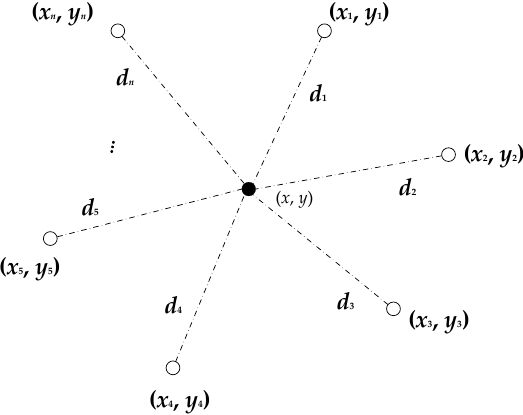
Figure 1. Schematic diagram of multilateral positioning.